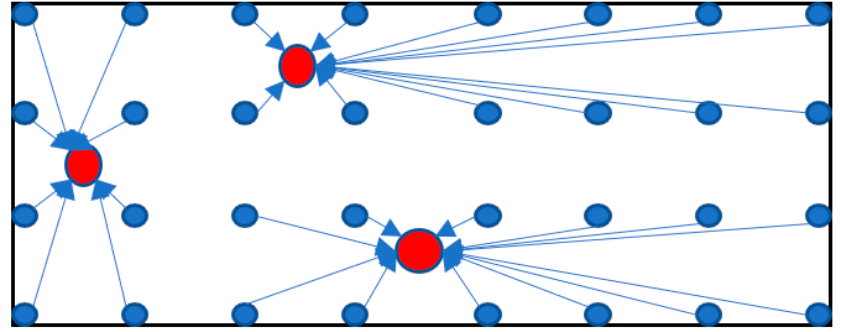
Figure 3. The red circle represents the measured data, the blue circle represents the remote sensing data, and the connected edges represent the fusion calculation of the remote sensing data with the measured data with the same cluster.